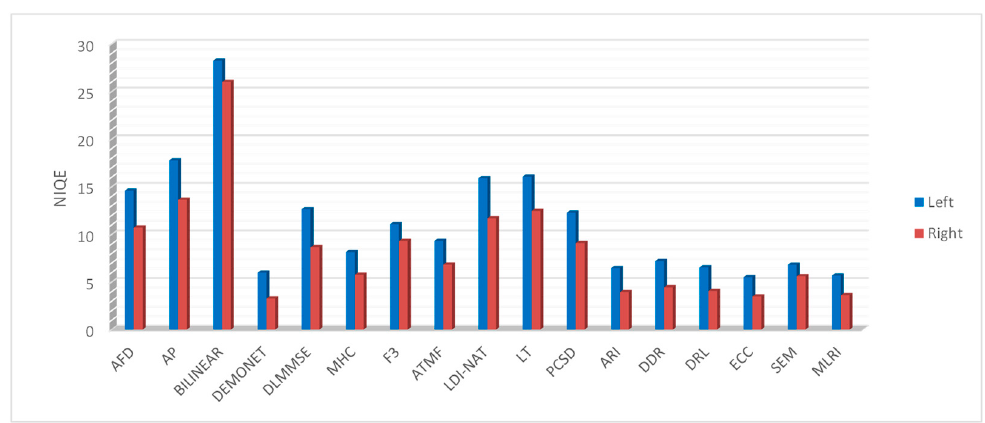
Figure 13. Averaged NIQE scores (RGB scores are averaged) of different methods for left and right images.